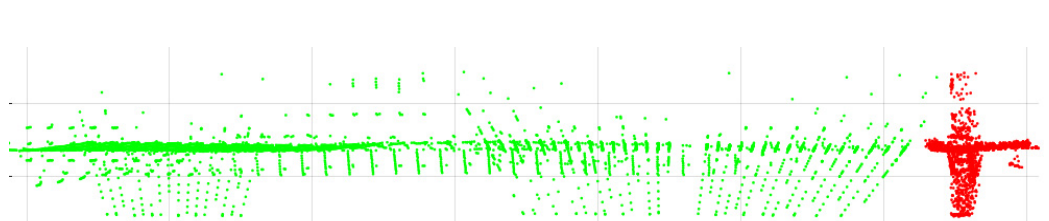
Figure 11. Green points mark the raw dataset captured from a taxiing aircraft during Test #1, and red points show the reconstructed airplane body using the CT method.